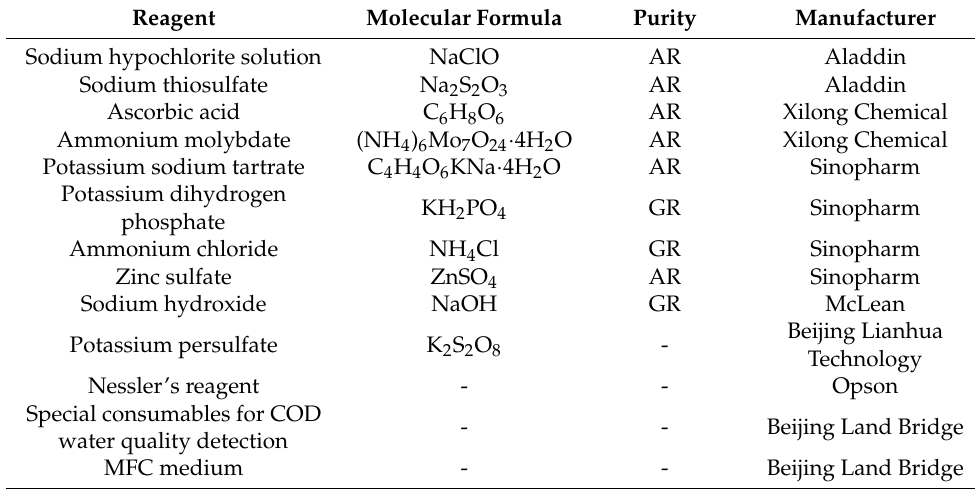
Table 2. Experimental reagents.